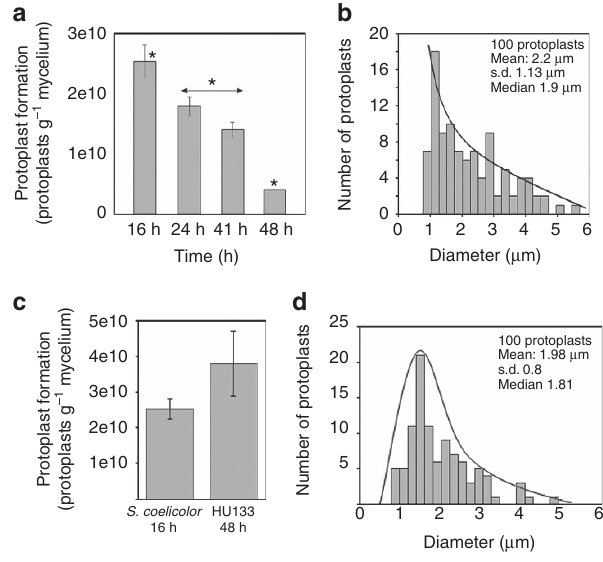
Figure 7 | Protoplast formation correlates with MI and compartmentalization in the ftsZ mutant HU133. ( a , b ) Protoplast formation in the S. coelicolor parental strain (presented as the number of protoplasts per gram of fresh mycelium) grown in GYM and a histogram of protoplast diameter at 10h. Significant differences in protoplast formation ( P value o 0.05; analysis of variance with Turkey’s HSD post hoc analysis) with respect to the 16h sample (MI) are labelled with an asterisk. ( c , d ) Protoplast formation in the D FtsZ HU133 mutant at 48h of growth in GYM and histograms of protoplast diameter. The error bars indicate ± s.d. of three biological replicates.